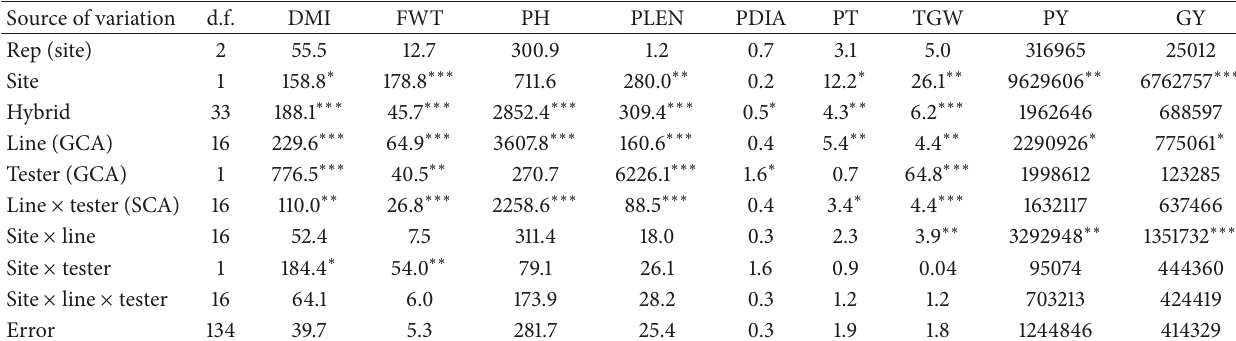
Table 5: Mean squares for combining ability for studied traits across locations.